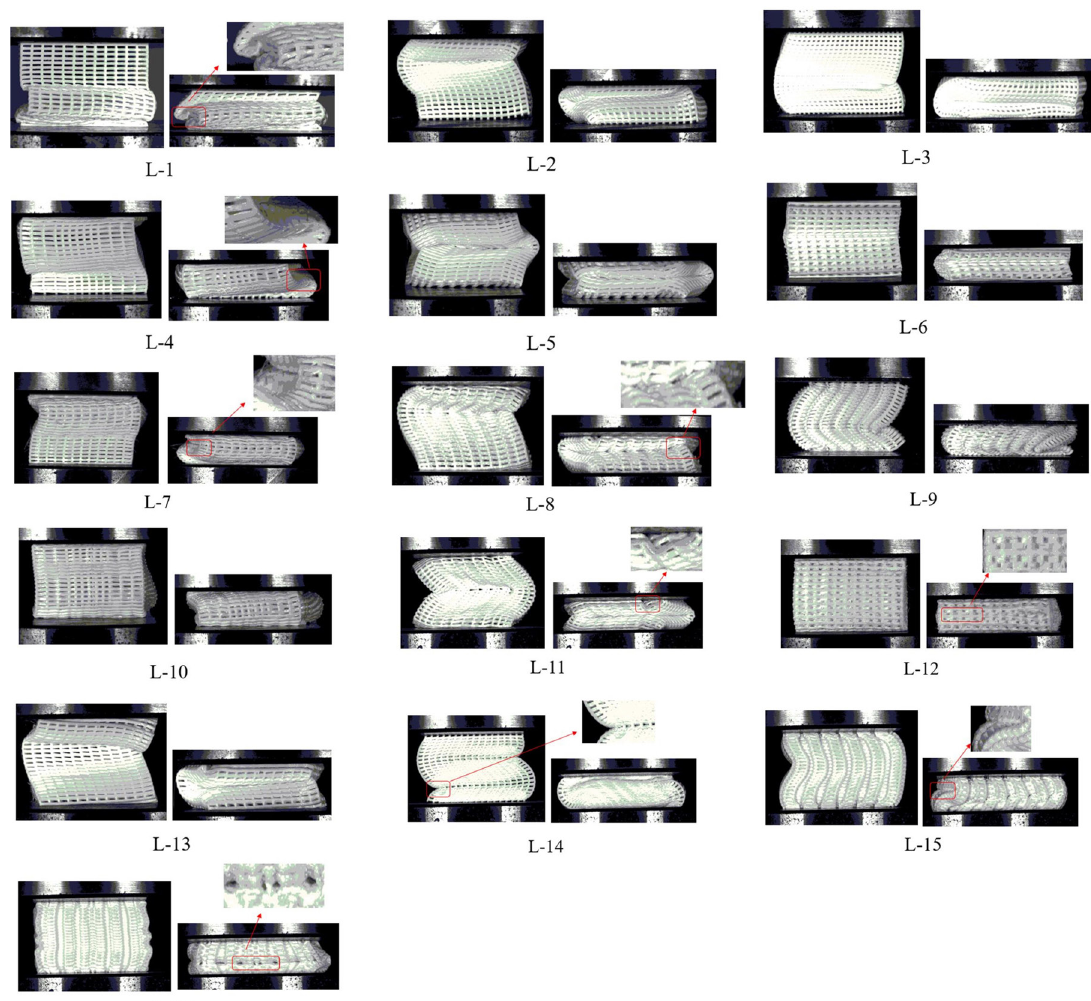
Figure 19. Deformation mode of lattice